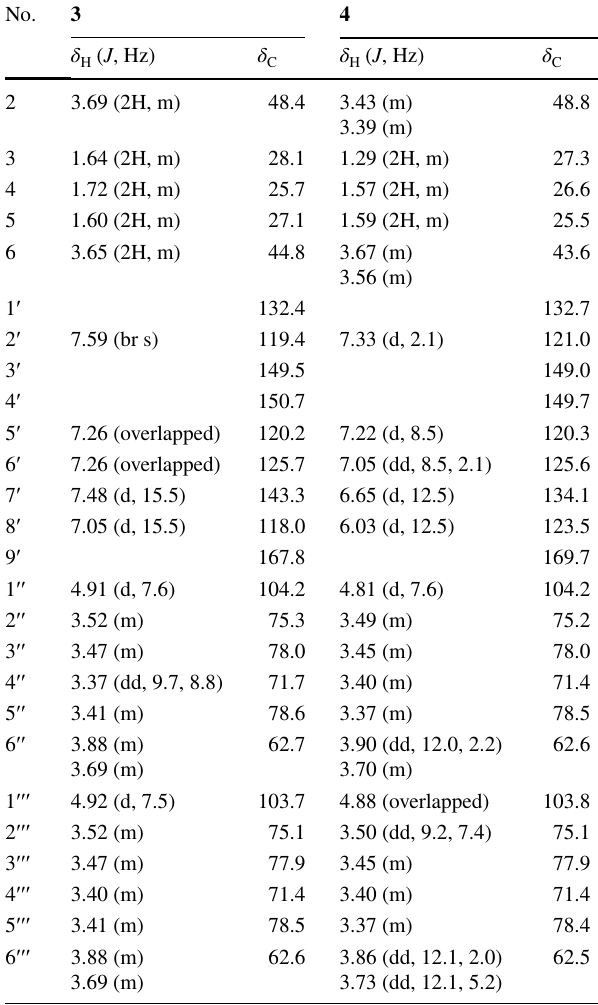
Table 2 1 H (600 MHz) and 13 C NMR (151 MHz) data of 3 and 4 in methanol- d